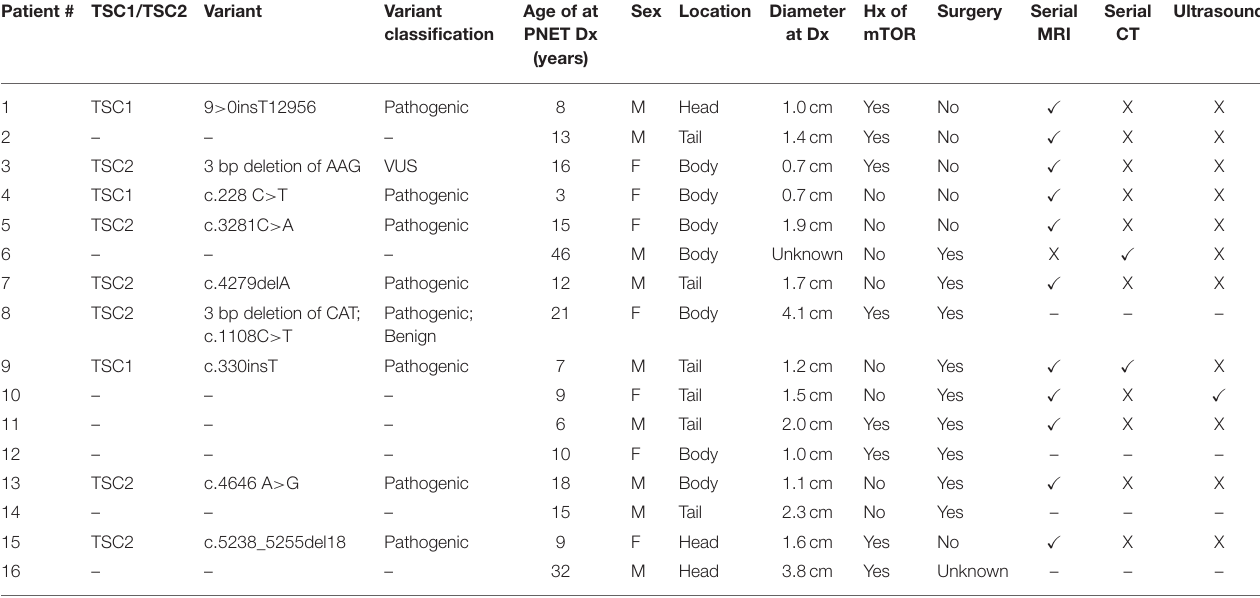
TABLE 1 | Clinical information of subjects with TSC diagnosed with nonfunctional PNET in our case series. Patient # TSC1/TSC2